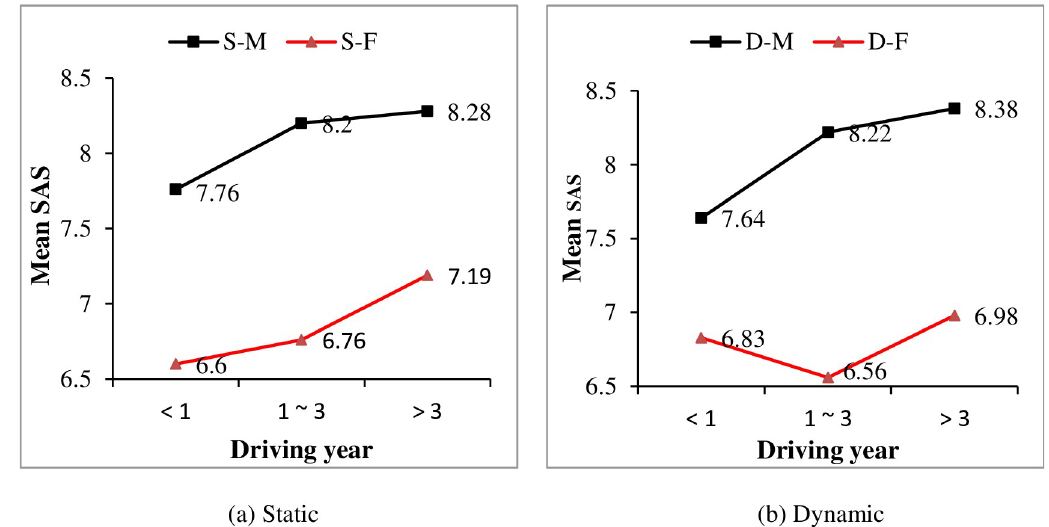
Fig 3. Effect of gender on self-assessment scores (SAS) under different driving year